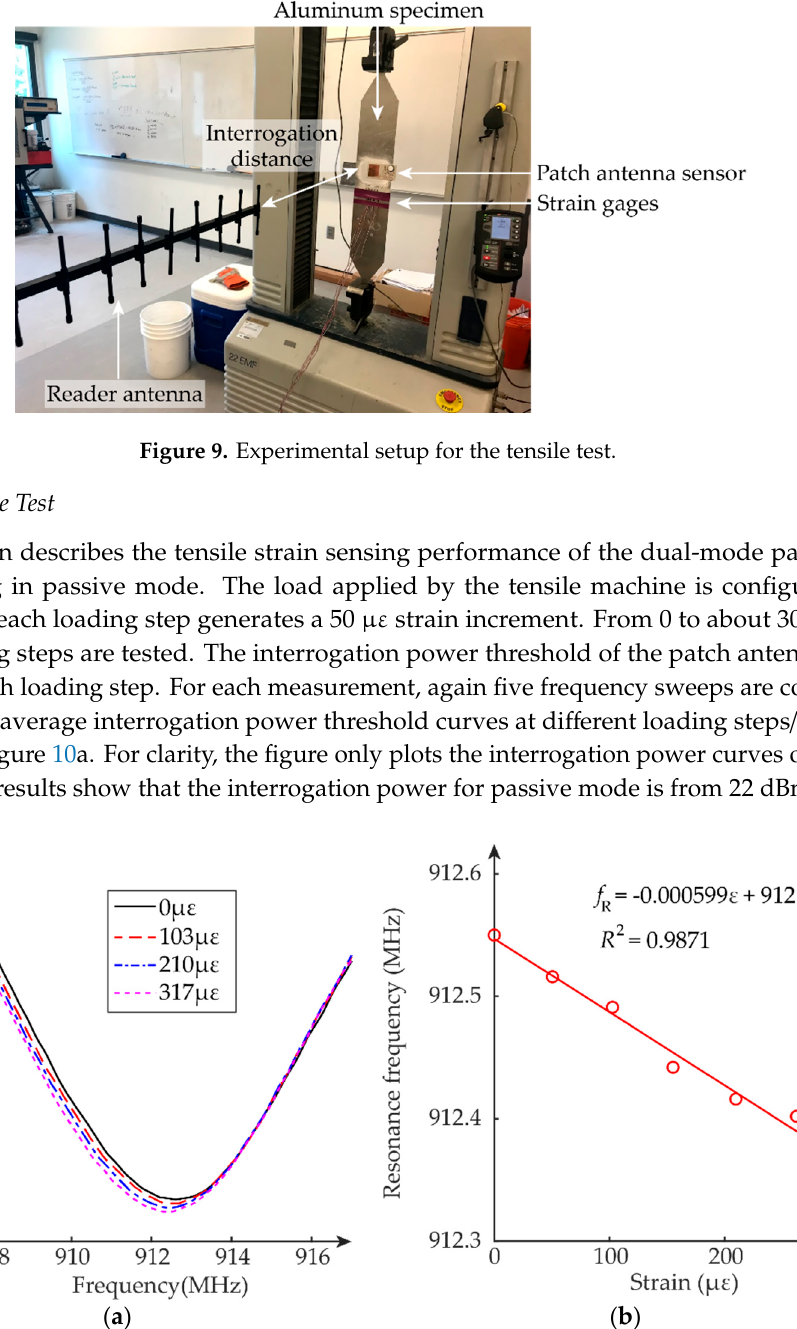
( a ) ( b ) Figure 11. Tensile test results of active mode test: ( a ) average interrogation power threshold, ( b ) resonance frequency 𝑓 (cid:2902) versus strain 𝜀 . 6. Crack Sensing Test To investigate the crack sensing performance of the patch antenna sensor, an emulated crack test is carried out. Figure 12 shows the crack test setup, including a crack testing device which is designed for emulating crack propagation. The crack testing device consists of three aluminum plates, i.e., a base plate, a rotating top plate, and a fixed bottom plate. The fixed bottom plate is fastened to the base plate by four corner bolts. The rotating top plate is attached to the base plate by one bolt at the bottom right corner, which acts as the rotation axis. All three plates are thick enough and can be assumed to remain rigid during crack testing for the sensor. A pair of angle brackets are fastened on the rotating top plate and the base plate. By turning a fine ‐ resolution control screw between the angle brackets, the top plate rotates along with the bolt and a crack/gap is opened between the top and bottom plates. With the probe pushing against an angle bracket attached to the top plate, a digital dial gauge (0.0001 in. resolution) is used to measure the crack opening size.